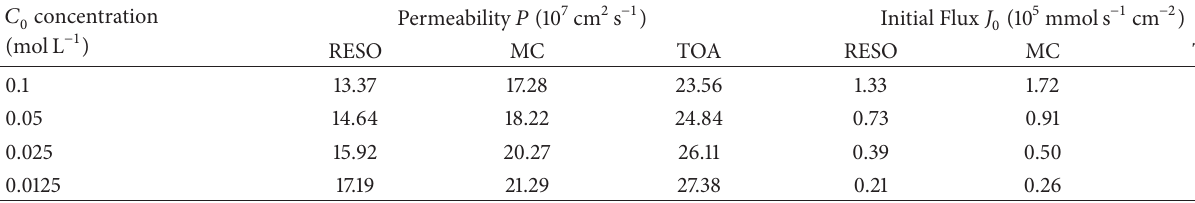
Table 2: The values of macroscopic parameters ( 𝑃 and 𝐽 0 ) on the facilitated extraction of VO 2+ ions by the three developed SLMs. 𝐶 0 concentration